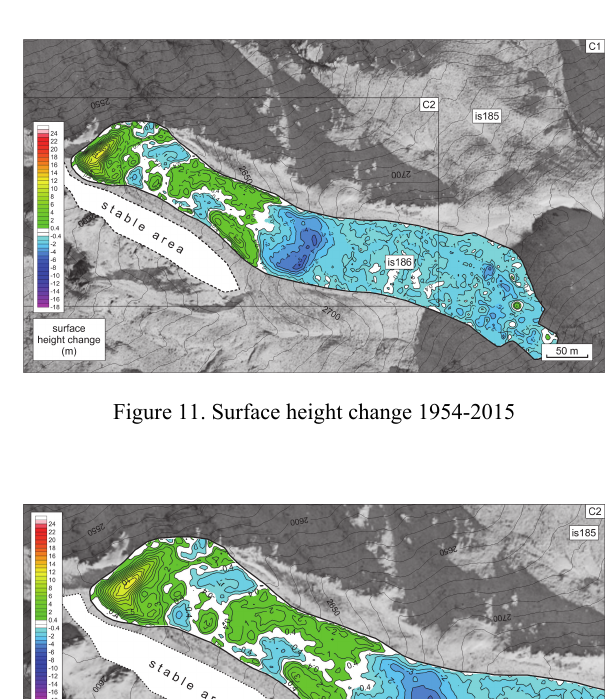
Table 10. Surface height change